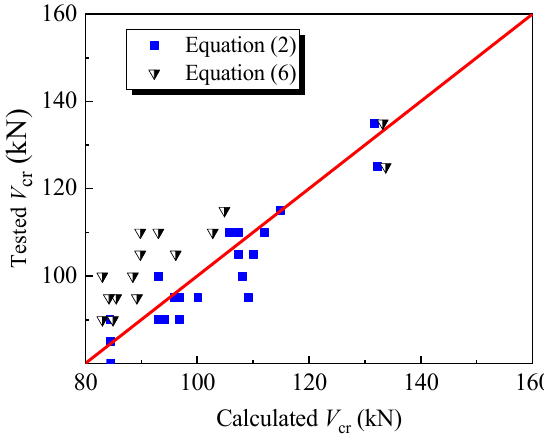
Figure 9. Comparison of tested and calculated values of V cr .